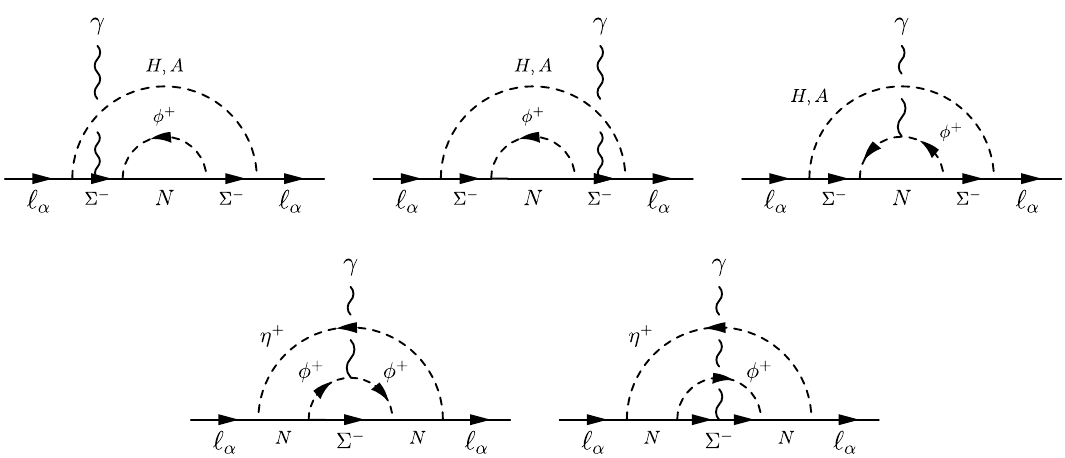
Figure 6 . Feynman diagrams inducing non-zero charged lepton EDM in the singlet-triplet extended model where η + , H and A are the charged, CP-even and CP-odd neutral components of the SU(2) doublet η ,